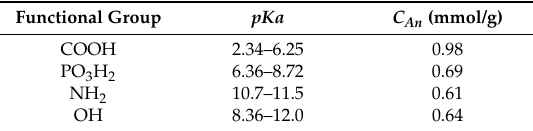
presented on the surface of moss biomass ( V. dubyana ) using modelling software ProtoFit ver. 2.1.